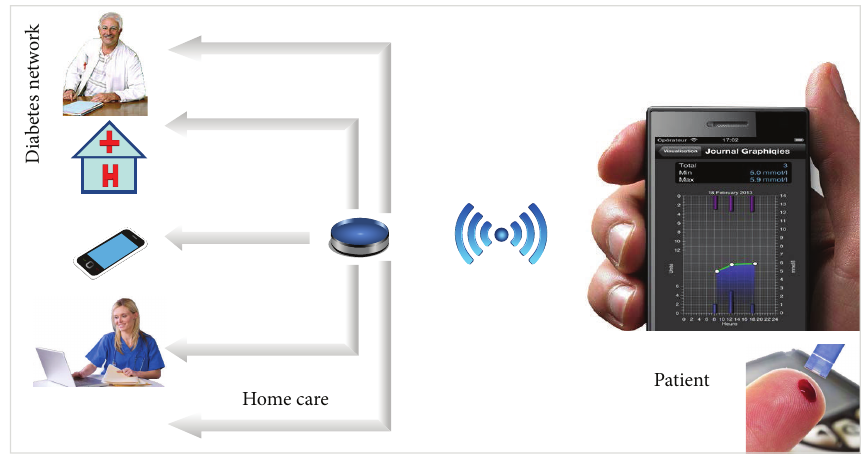
Figure 1: Mobil Diab system components.